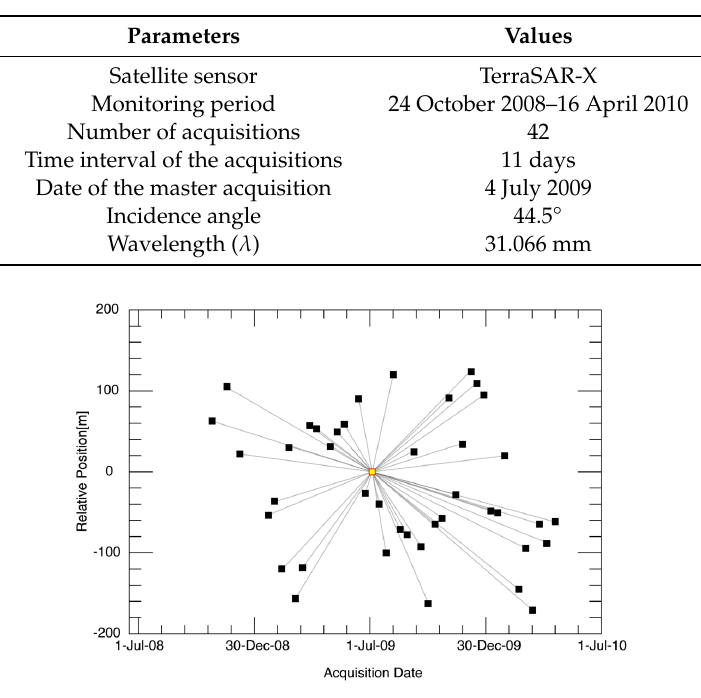
Table 2. Data description.